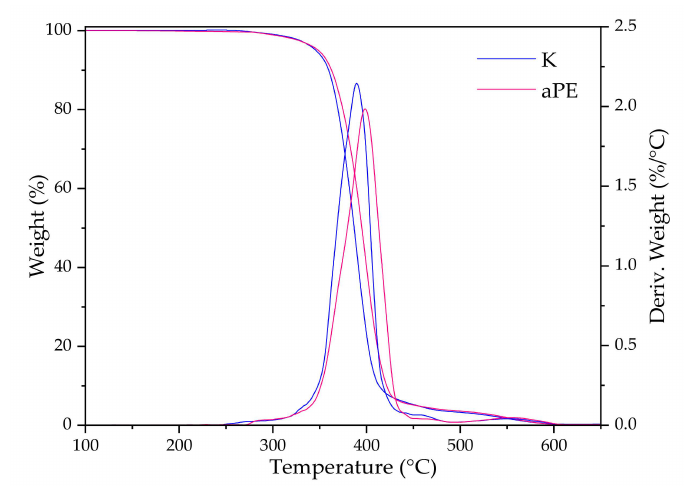
Figure 11. TG and DTG curves of K and PE